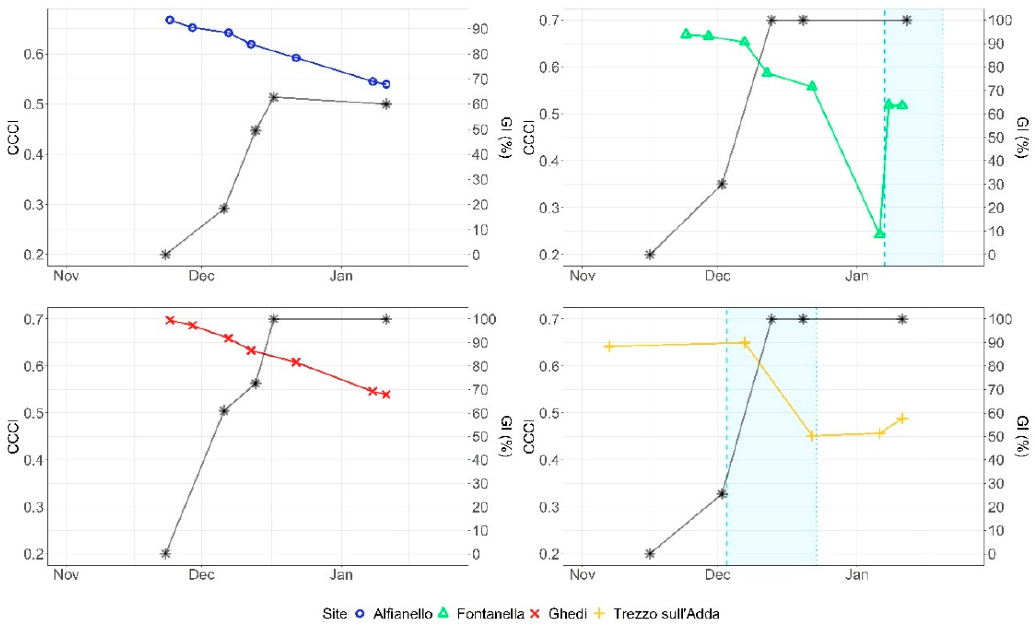
Figure 4. Trends of the vegetation index NDRE (Normalized Index Red-Edge) and of ground-measured frost index of a white mustard cover crop (GI, %) in the four monitoring sites. GI is represented with grey stars (*), the starting date of the first frost event estimated from NDRE with the ‘peak-based method’ is a vertical light-blue dashed line, while the end is a vertical light-blue dotted line.